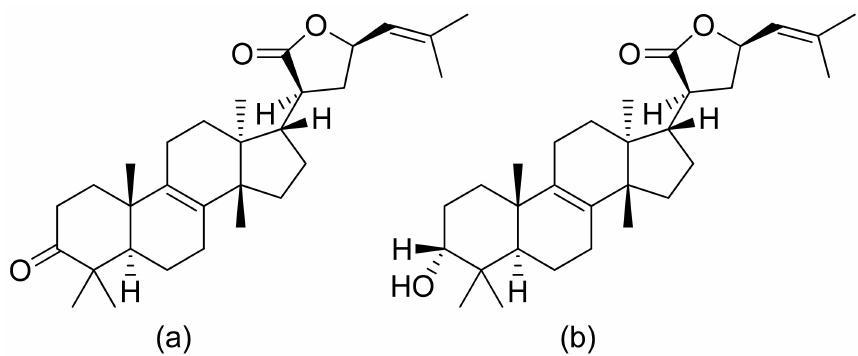
Figure 18. Triterpenoid lactones from the oleo-gum-resin of Boswellia serrata ( a , b ) .